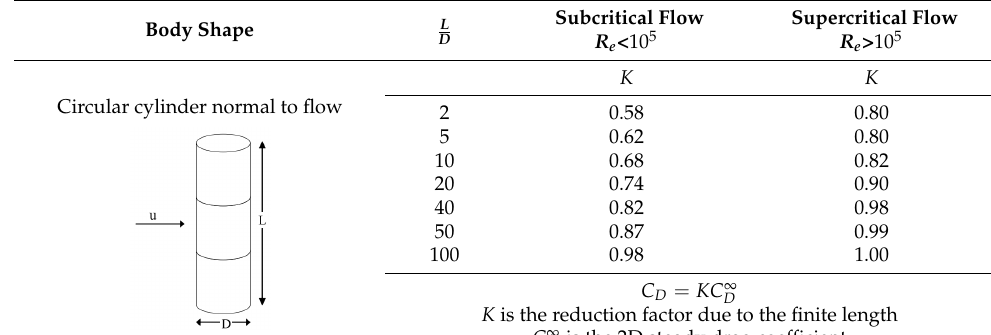
Table A5. Drag coefficients for the flow normal to the circular cylinder (reproduced from [48], with permission from DNV, 2021).